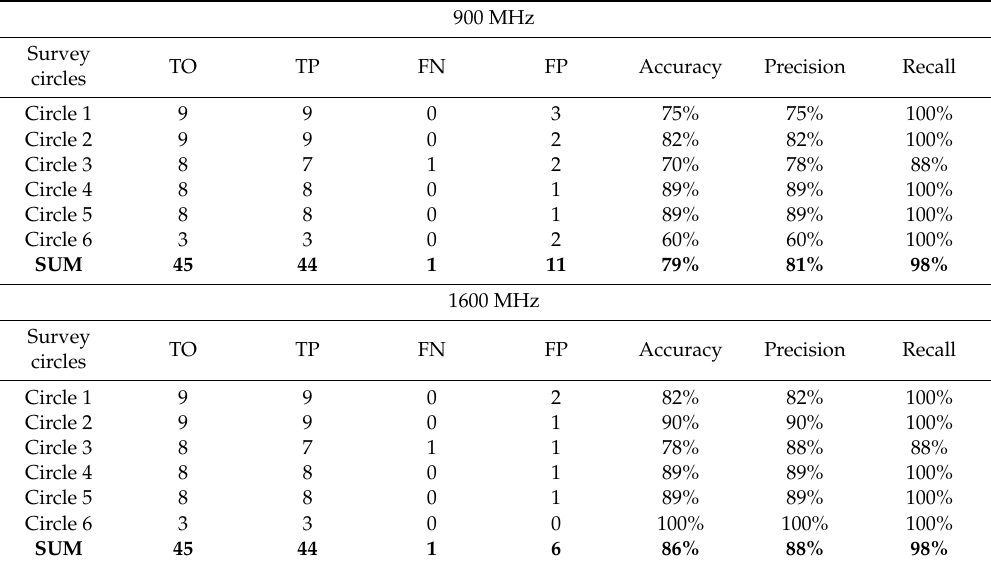
Table 8. Detection accuracy, precision, and recall of the simulated